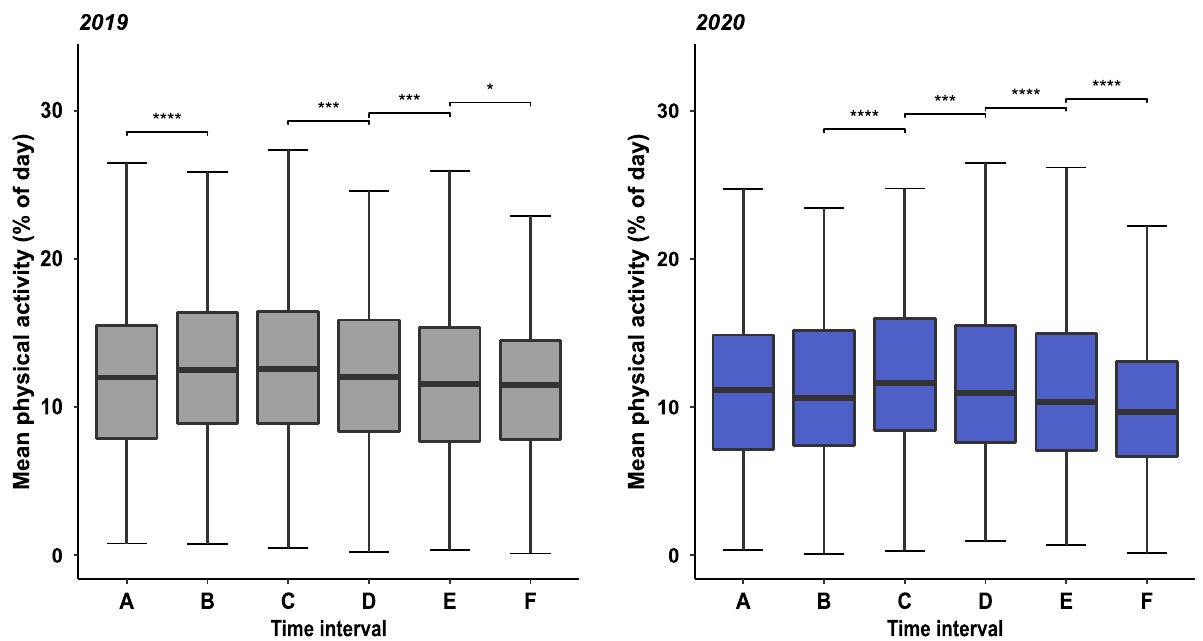
Fig 3. Comparison of physical activity of adjacent time intervals in 2019 and 2020. Box-Whisker-Plots of mean physical activity. Intervals A to F, marking time intervals with different levels of health restrictions in 2020 are annotated and transferred identically to the year 2019. Significant changes in physical activity between adjacent intervals throughout the year are annotated ( � = p < 0.05, �� = p < 0.01, ��� = p < 0.001, ���� = p < 0.0001).